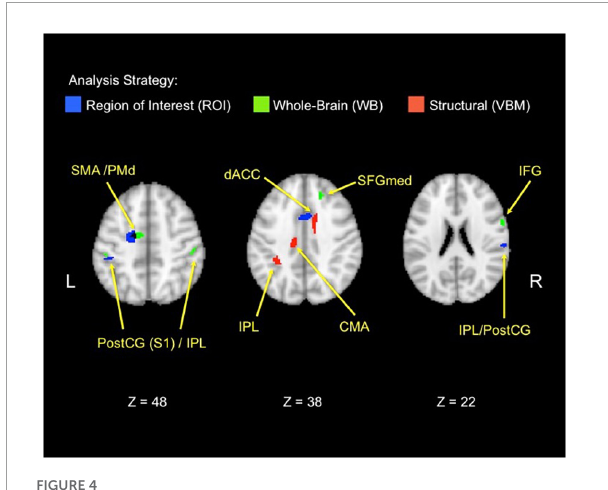
FIGURE4 Functional and structural correlates of the behavioral donation interaction. The figure displays brain areas that significantly increase activation with the strength of the three-way behavioral donation interaction (higher for neonates as immediacy increases for nurturant aid but not heroic). Results are combined across analysis strategies including ROI analyses from the retrieval localizer and the a priori regions from a prior study (blue), whole-brain functional regions (green), and voxel-based morphometry (VBM) (red) analyses. The VBM threshold was dropped for the figure only to facilitate viewing to 0.005, uncorrected. CMA, cingulate motor area; PostCG(S1), postcentral gyrus/primary somatosensory area; IFG, inferior frontal gyrus; IPL, inferior parietal lobule; PMd, dorsal premotor area; SFGmed, medial superior frontal gyrus; SMA, supplementary motor